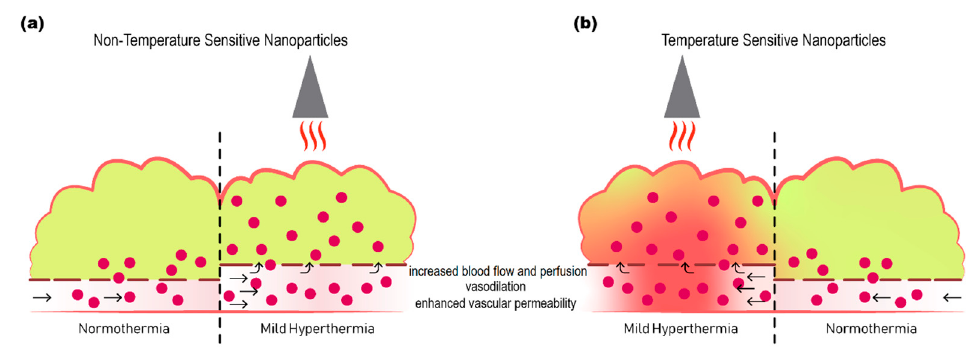
Figure 1. Schematic representation of the e ff ect of mild hyperthermia on drug delivery to tumors. Delivery of non-temperature sensitive nanoparticles ( a ), or temperature sensitive nanoparticles ( b ) to tumor is enhanced by application of mild hyperthermia. Mild hyperthermia increases regional blood flow and perfusion, causes vasodilation, and increases vascular permeability, resulting in increased extravasation and more homogeneous distribution of nanoparticles deeper into the tumor. When combined with temperature sensitive nanoparticles the additional advantage is increased cellular delivery of free drug upon release from the nanoparticles in response to